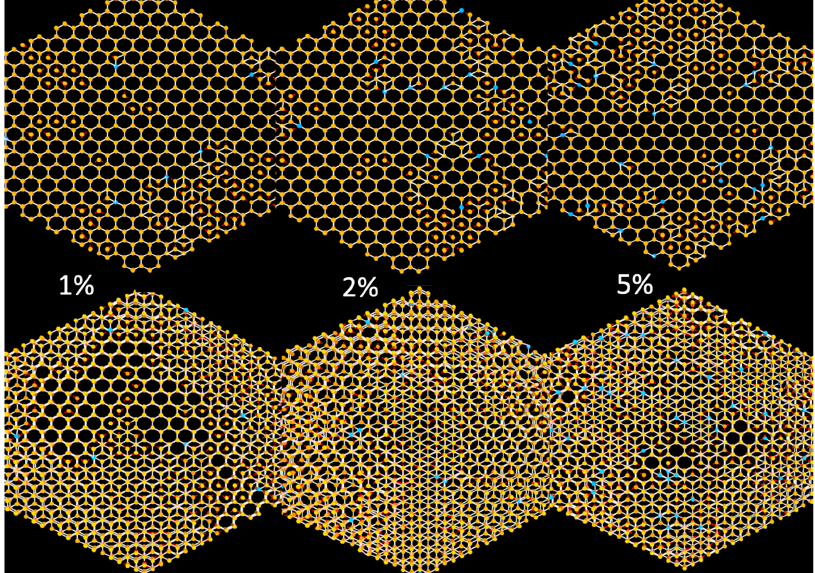
Figure 5. Screen shots of the Monte Carlo simulation of a 9-layer COF simulation that illustrates the influence of the percentage of linear defects (blue lines are not terminated in a hexagon and indicate links to a layer above or below) on the lattice. The top row shows the single layer where growth was initiated (nucleation layer), while the bottom row shows the central three layers, with one above and one below the nucleation layer. Orphan bonds are indicated by small red rods. The 1% defect probability simulation shows that a high percentage of hexagonal channels can span multiple layers but will not line up to form channels even with a few more than 3 layers. Remarkably, a mere 2–3% of linear defects will seriously affect the ability of the layers to form pores spanning the width of the three-layer slice of the nine-layer simulation.